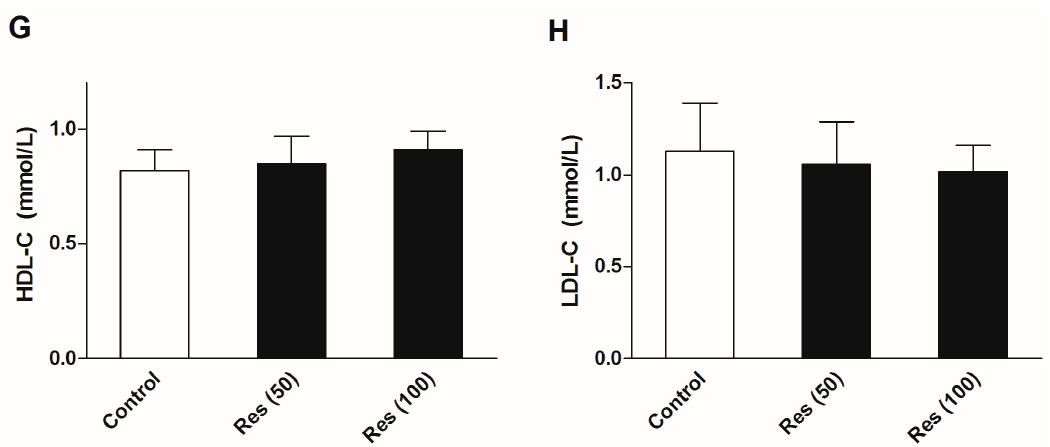
Figure 7. Effects of resveratrol on the serum biochemical levels in normal mice. ( A ) The curve of blood glucose level during OGTT; ( B ) The area under curve during OGTT; ( C ) The fasting serum glucose level; ( D ) The fasting serum insulin level; ( E ) Serum level of TG; ( F ) Serum level of TC; ( G ) Serum level of HDL-C; ( H ) Serum level of LDL-C. Data were expressed as the mean ± S.E.M. ( n = 10). One-way ANOVA followed by Dunnett’s post hoc test were used for statistical analysis.